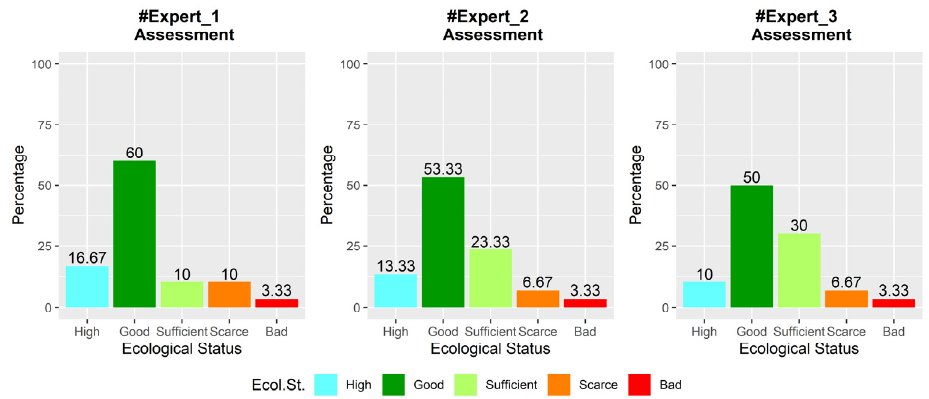
Figure 3. Ecological status of sampling sites assessed by three blind expert judgements.